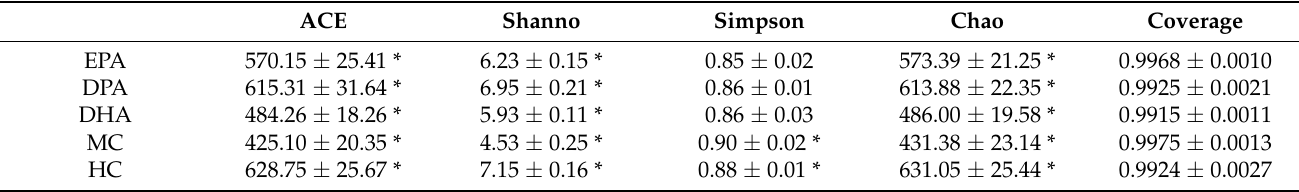
Table 1. Alpha diversity of samples for all groups (* p < 0.05).